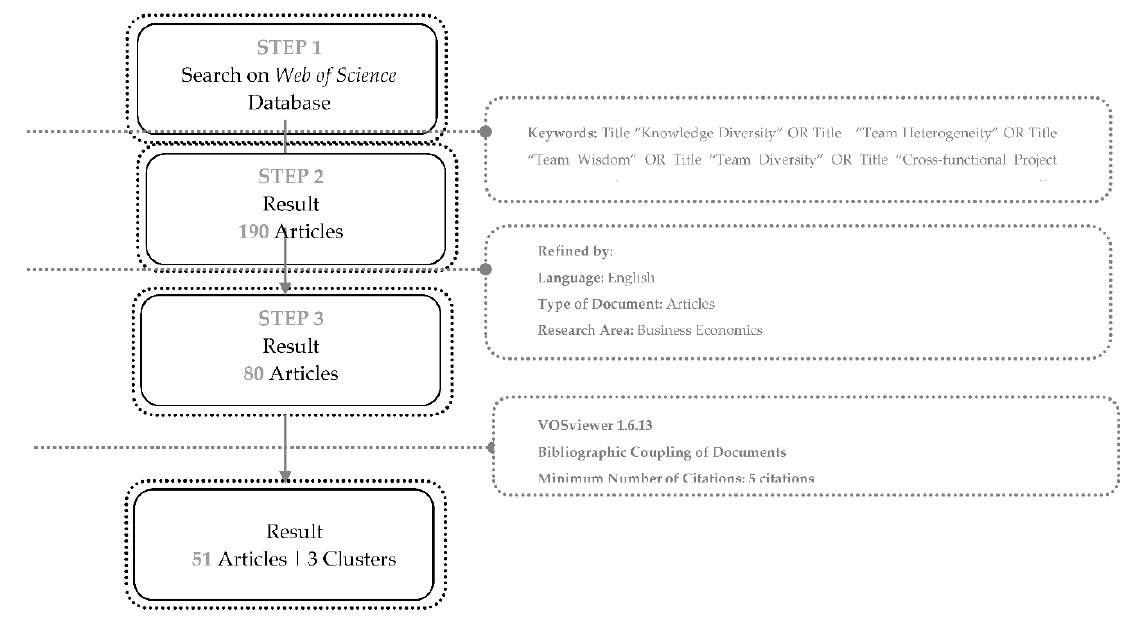
Figure 1. Search Protocol.